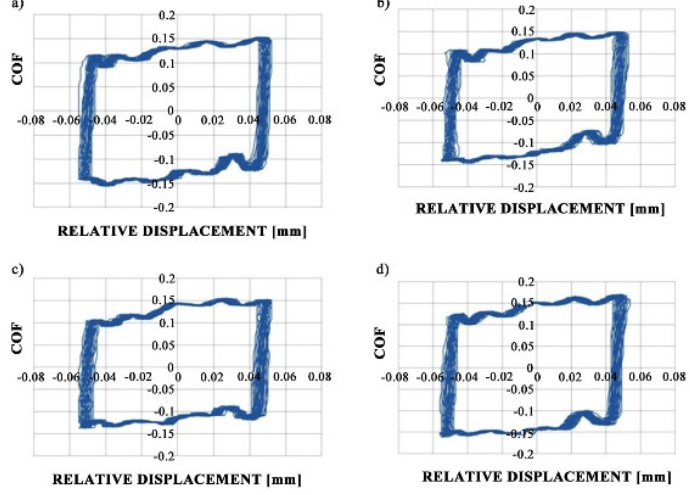
Figure 13. Fretting loops for assemblies with M3 ( a , c ) and VB1 discs ( b , d ) during tests C ( a , b ) and D ( c , d ).